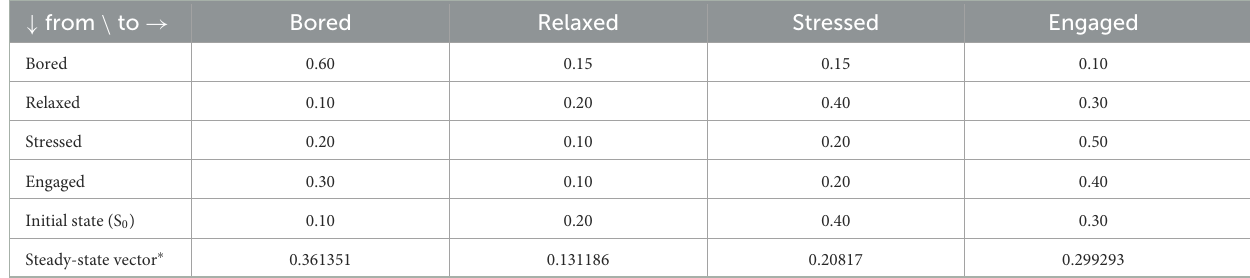
TABLE 1 State transitions matrix, with initial state (S 0 ) and the calculation of the steady-state vector. ↓ from \ to →